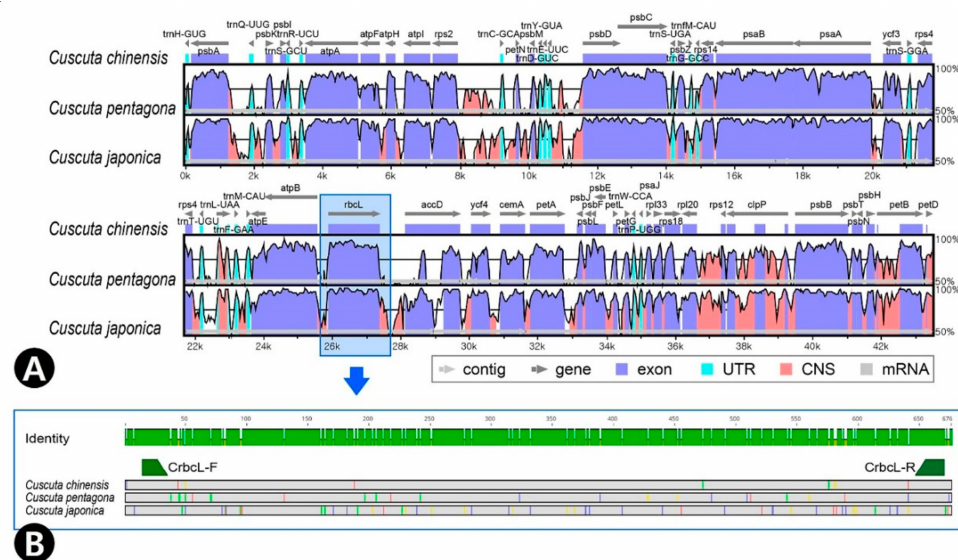
Figure 5. Schematic diagram of Cuscuta chloroplast genomes and novel DNA barcode primer design using rbcL . ( A ) Comparative analysis of the chloroplast genomes of three Cuscuta species using mVISTA, with the C. japonica chloroplast genome as the reference. Blue block, conserved genes; sky-blue blocks, tRNA and rRNA genes; red blocks, conserved non-coding sequences (CNSs); white blocks, polymorphic regions among the three Cuscuta species. A 50% identity cut-o ff was used for the plots. The Y -axis represents 50–100% identity. ( B ) Green arrows indicate novel DNA barcode primers. Colored regions indicate variable sequences in the three Cuscuta